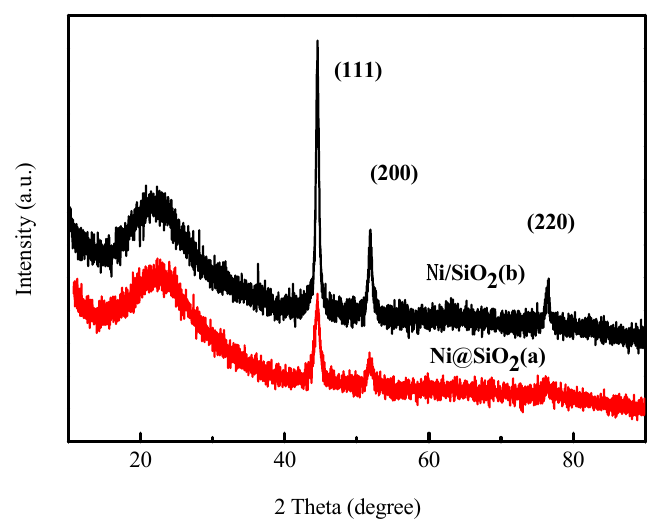
Figure 2. XRD patterns of the Ni@SiO 2 ( a ); and Ni/SiO 2 ( b ) catalysts both after situ reduction. The surface area, pore volume, and average pore size of NiO@SiO 2 and NiO/SiO 2 are shown in